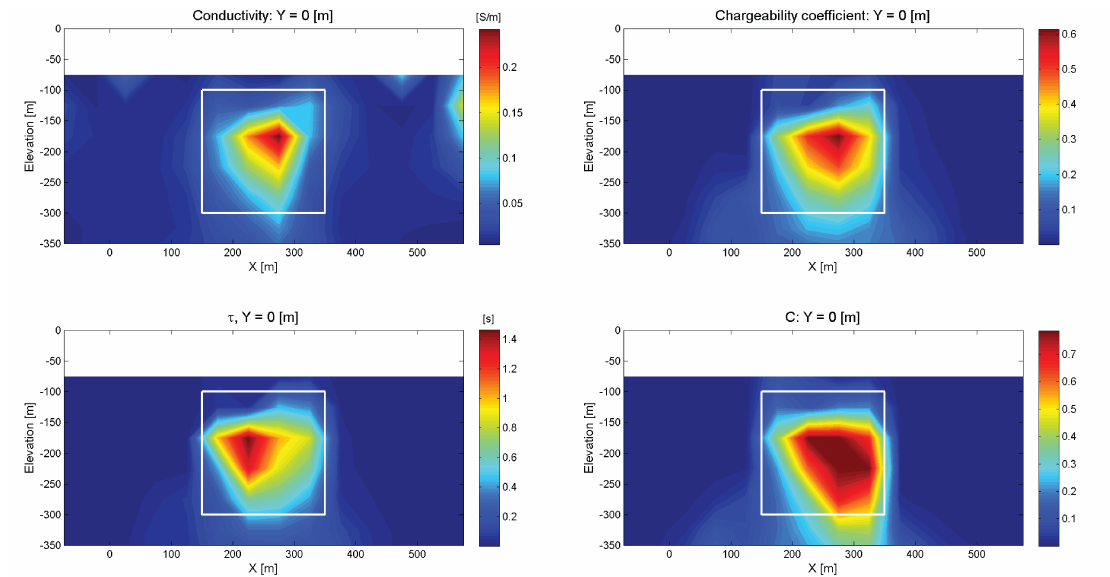
Figure 2. Vertical cross sections of the GEMTIP model parameters (DC anomalous conductivity, fraction volume, time constant, and relaxation parameter) recovered from the 3D inversion of frequency-domain SIP data.